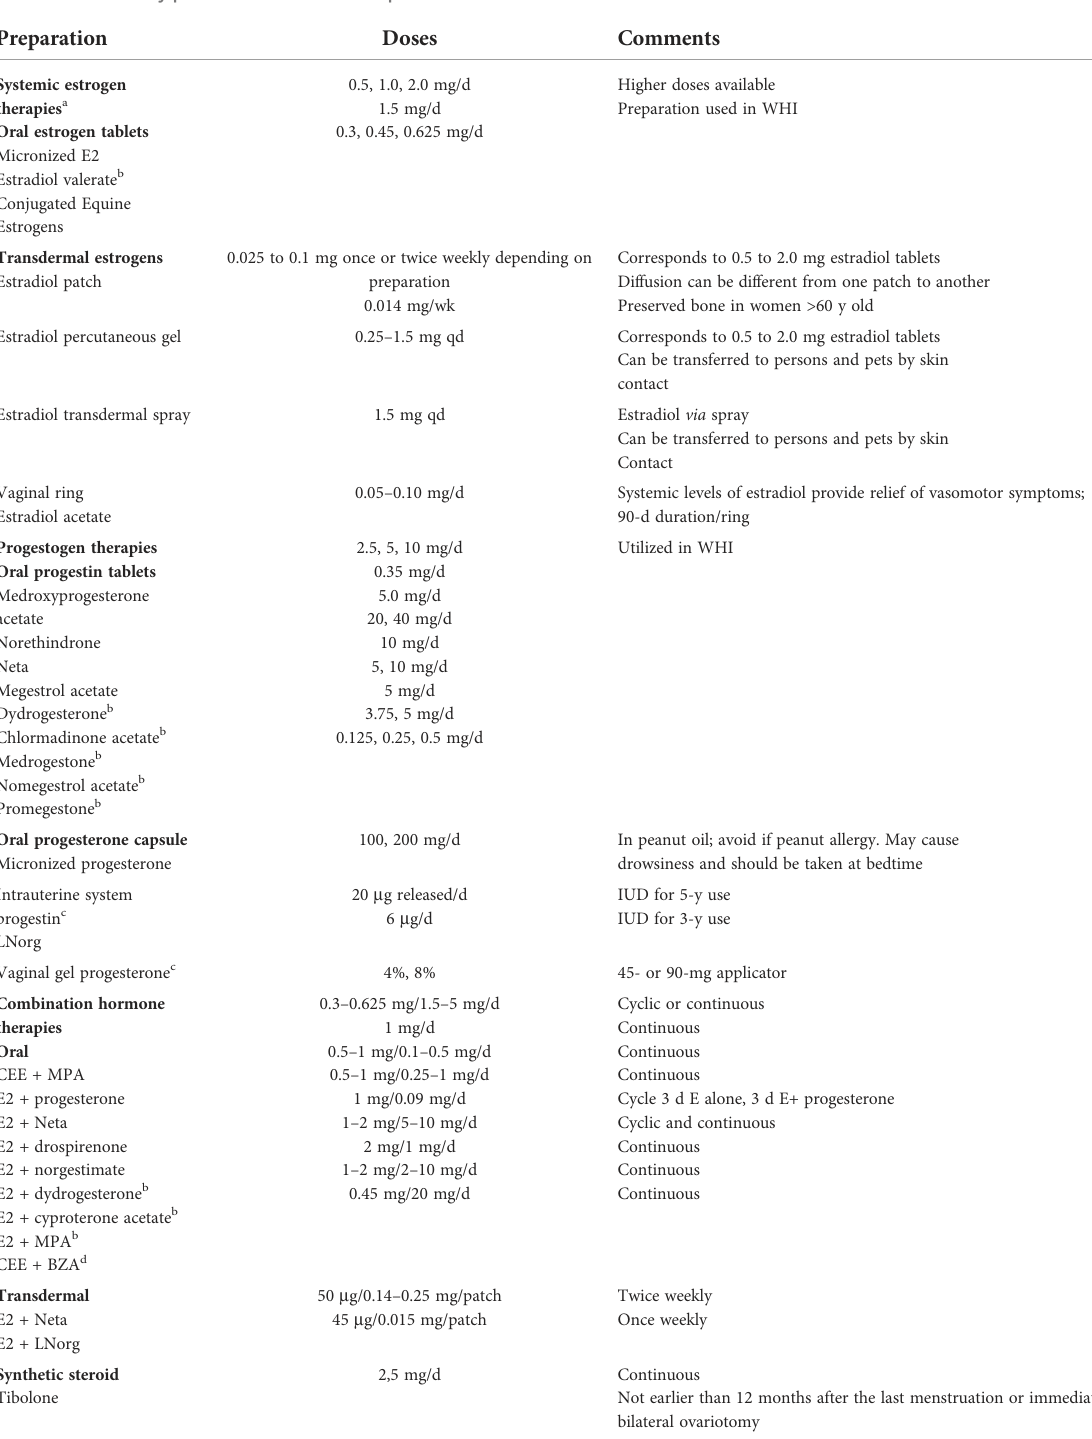
TABLE 3 Commonly prescribed hormone